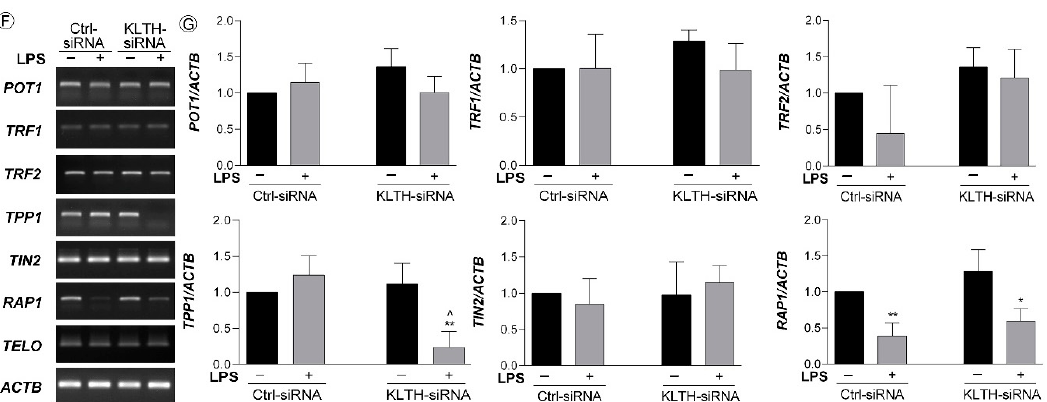
Figure 4. Klotho-silencing results in oxidative-mediated DNA and telomere instability. The cells were transfected, treated for 48 h with LPS and then, the following parameters were controlled: ( A ) micronuclei formation; ( B ) H2A.X phosphorylation; ( C ) cell cycle profile; ( D – E ) expression of proteins associated with cell cycle arrest; ( F – G ) expression of genes of shelterin complex. Yellow arrows indicate micronuclei. Magnification of the objective lens × 20; scale bar, 100 µm. Bars indicate SD, n = 3, ^^^ p < 0.001, ** p < 0.01, */^ p < 0.05, no indication/no statistical significance (one-way ANOVA and